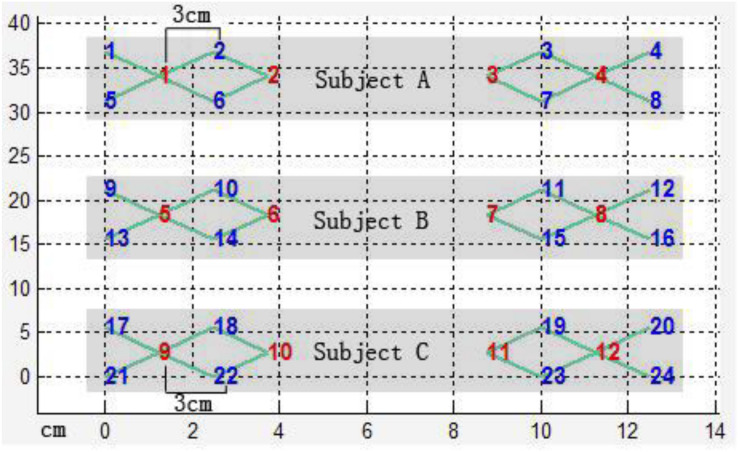
Distribution of laser optodes (red) and detectors (blue).